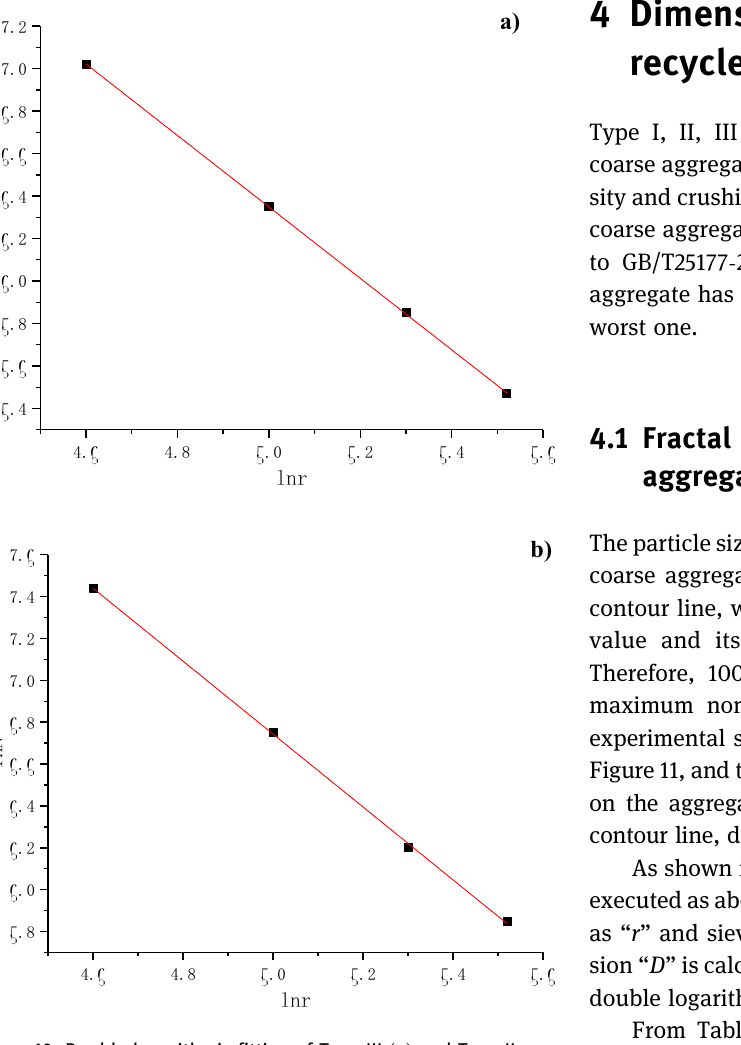
Figure 10: Double logarithmic fi tting of Type III ( a ) and Type II recycled sand in particle group state ( b ) .